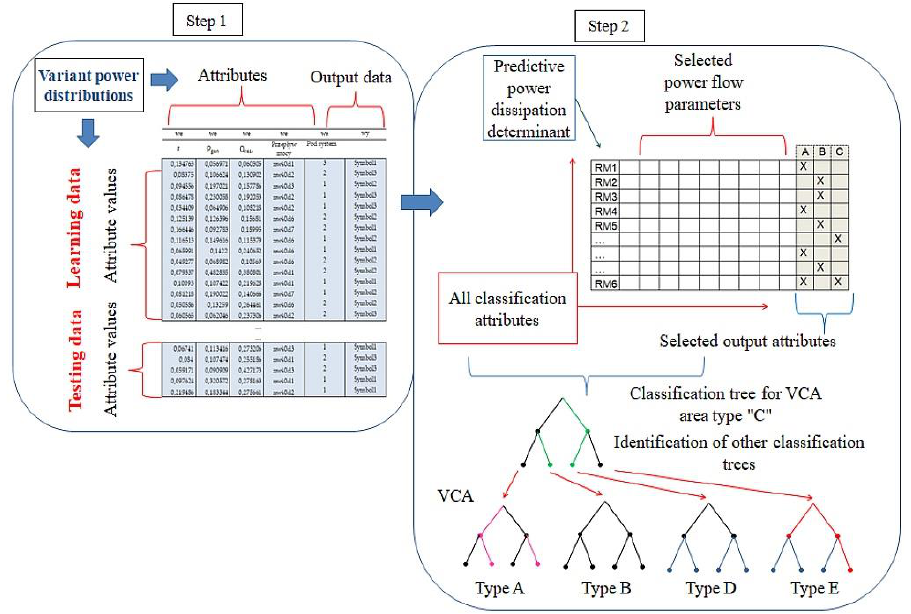
Figure 13. Knowledge generation in terms of decision tree classification in two stages.